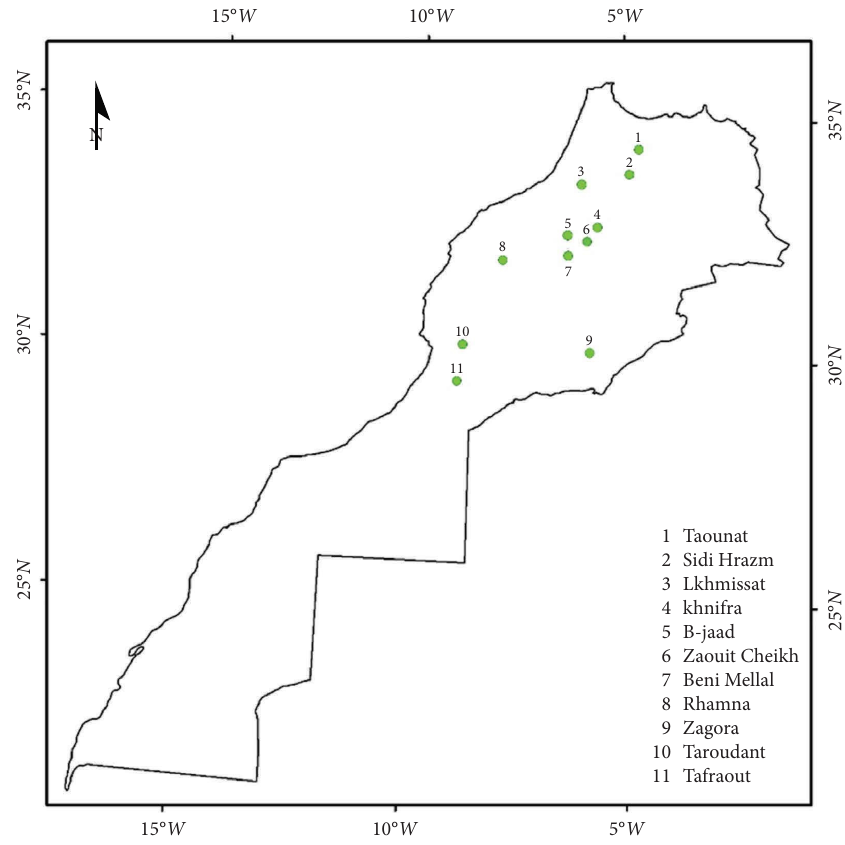
Figure 1: Map of Morocco showing sampling